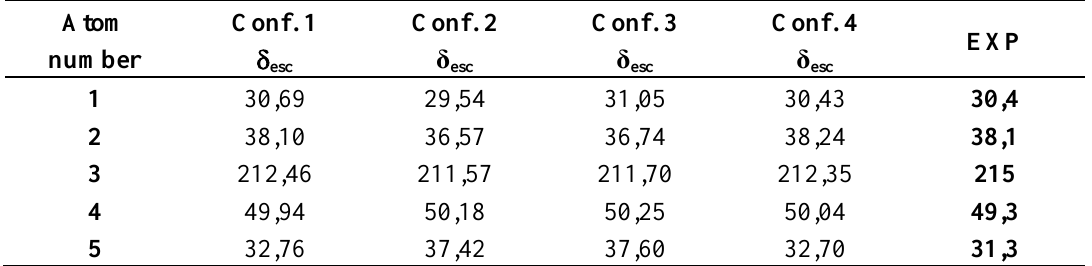
Table 2. Comparison of the theoretical 13 C-NMR chemical shifts for the four possible diastereomers of 3-ishwarone with experimental